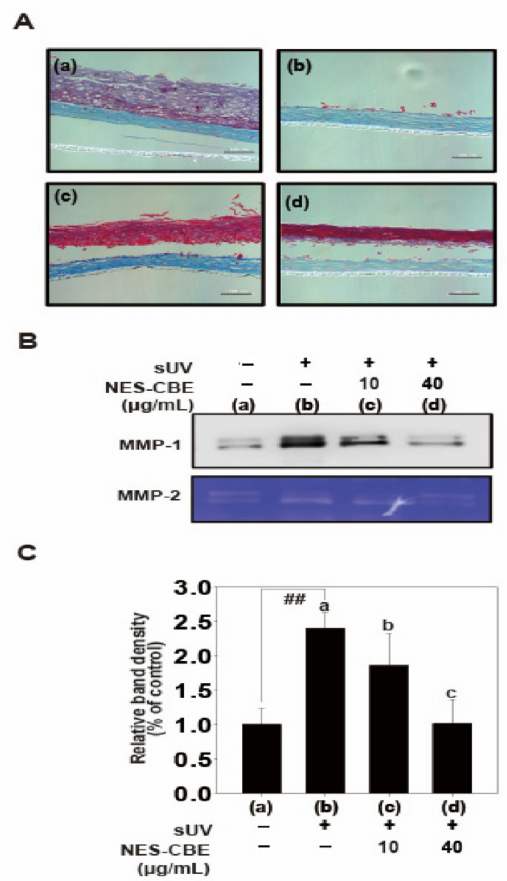
Figure 5. ( A ) NES-CBE inhibits sUV-induced skin damage and MMP-1 protein expression in a human skin equivalent model. ( B ) Human skin equivalent tissue was pretreated with different concentrations (10 to 40 µ g/mL) of NES-CBE for 1 h and then exposed to 25 kJ/cm 2 sUV twice a day for two days at 2 h intervals. 24 h after the last sUV irradiation, the medium was harvested for MMP-1 expression. The human skin equivalent tissue was fixed in 4% formaldehyde solution for Masson’s trichrome staining. Scale bar shown at 100 µ m. ( C ) Untreated controls: (a) sUV (25 kJ/m 2 ) only, (b) sUV and NES-CBE (10 µ g/mL), (c) sUV and (d) NES-CBE (40 µ g/mL). Image Studio software (LI-COR) was used for band density measurement. The experiment was performed in triplicates and bars marked with different letters (a–c) are significantly different ( p < 0.05, ## p < 0.01), relative to the control cells with one-way ANOVA. Duncan’s Multiple Range test was used as a post hoc test to measure specific